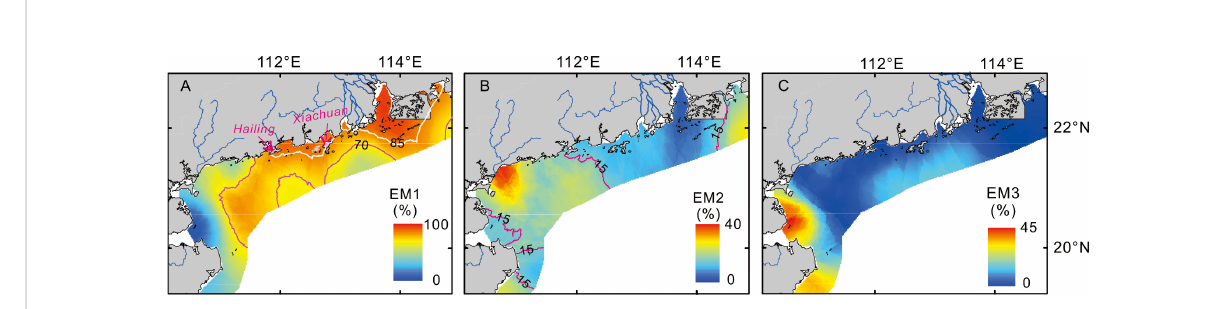
FIGURE 3 The distribution maps of three grain-size end-members (A: EM1; B: EM2; C: EM3) of surface sediments are shown on the north-western South China Sea shelf. Two solid lines in Figure 3A label the EM1 content of 85% and 70%. The purple solid lines in Figure 3B represents the EM2 content of 15%.